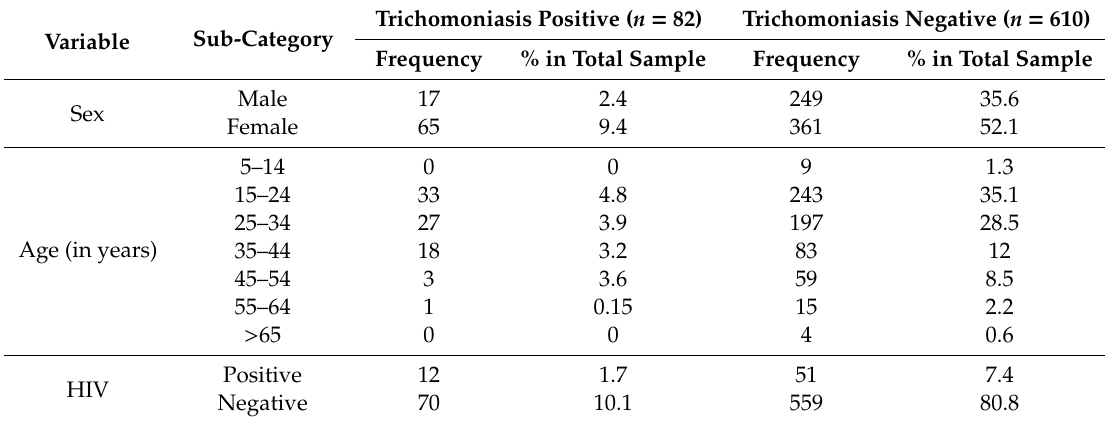
Table 1. Comparison of demographic variables like sex, age and HIV positivity in the participants of the